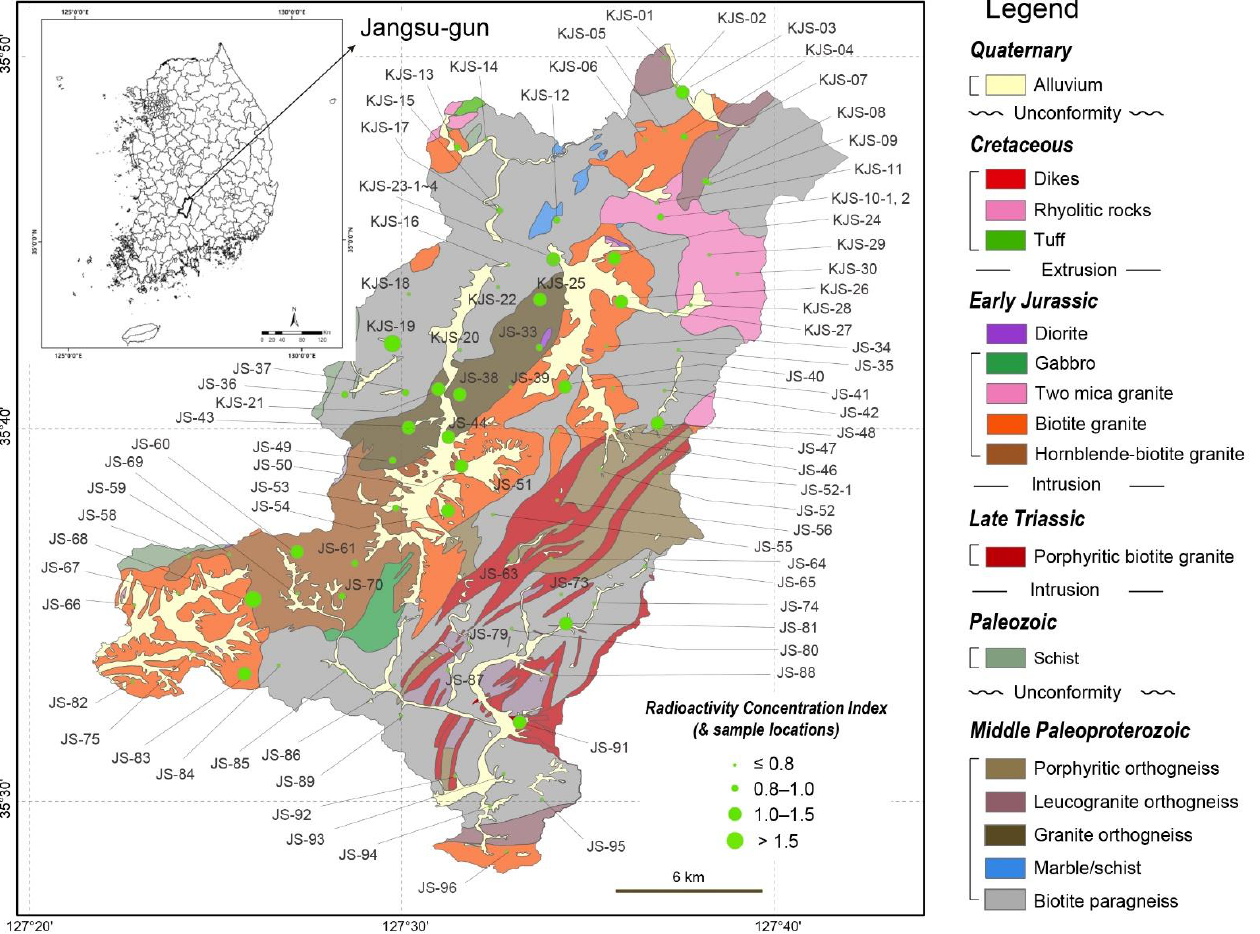
Figure 2. Sketch geologic maps of the Jangsu-gun area from the Southwestern Yeongnam massif, South Korea, showing the locations of samples analyzed in the present study.